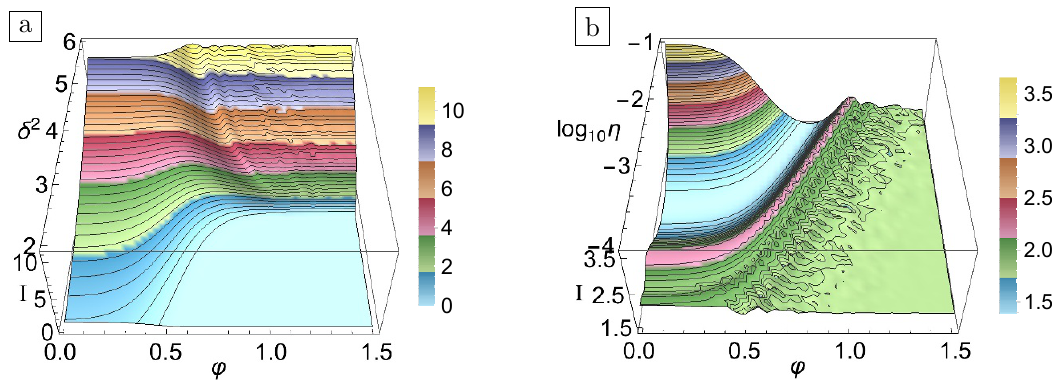
Figure 7 . Plots for I LCFA edges for the (cid:12)rst case in (cid:12)gure 4, with (cid:17) k = 0 : 1, (cid:24) = 10, (cid:8) = 0 : 2, - (cid:14) 2 = 4 : 1 (unless these parameters are varied in the plot). Left: the transition from below- to above-the-threshold behaviour. Right: the role of the energy parameter in increasing decay in the magnetic (cid:12)eld region. (The colours represent the vertical axis height as denoted by the scale alongside each